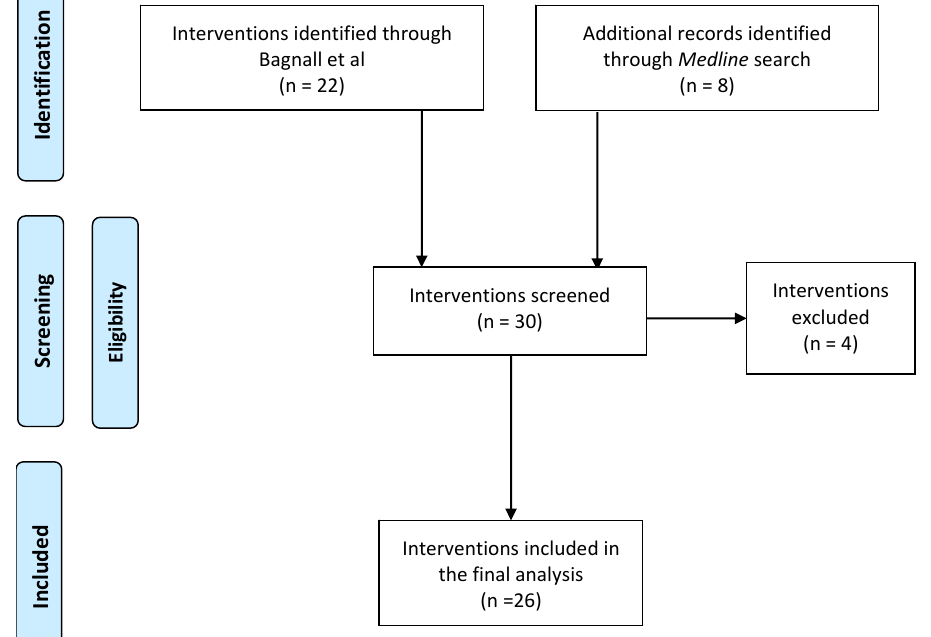
Figure 1. Summary of study selection.